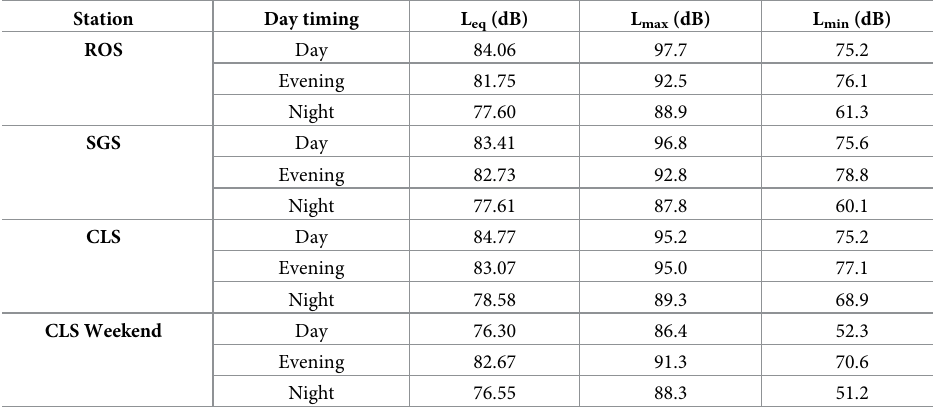
Table 11. The mean equivalent sound pressure level (L eq ), the maximum sound pressure level (Lmax) and the minimum sound pressure level (L min ) in (dB) at each of the selected stations.